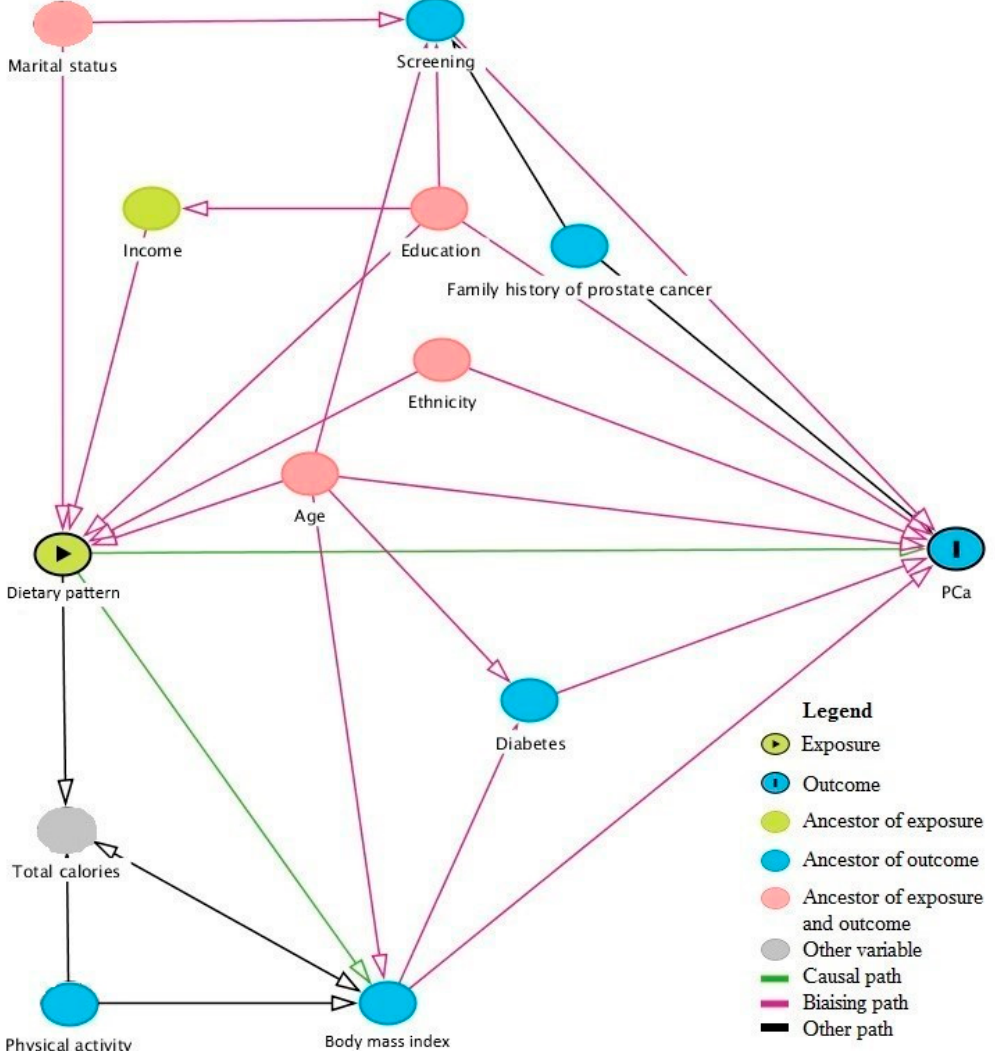
Figure 1. Directed acyclic graph for the association between dietary patterns and prostate cancer risk.